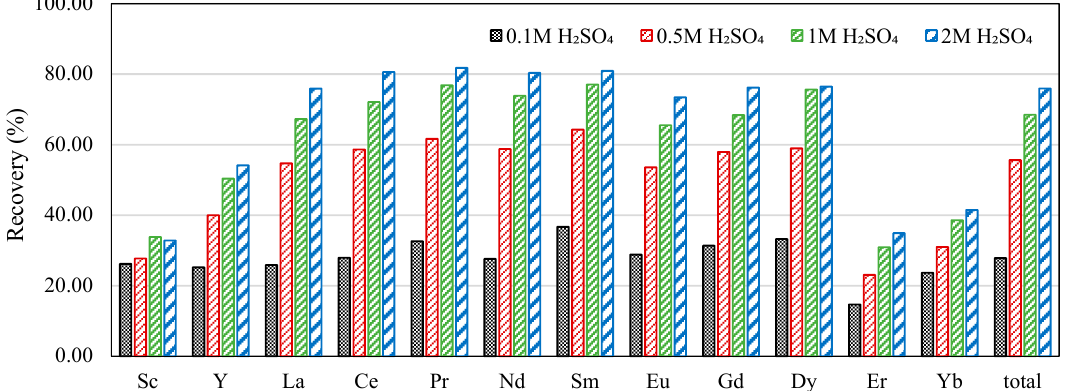
Figure 8. Effect of sulfuric acid solution concentration on the leaching recovery of total rare earth elements contained in the Fire Clay coal middlings (75 °C , 530 rpm, S/L = 10g/L, D 80 = 8.7 μ m).